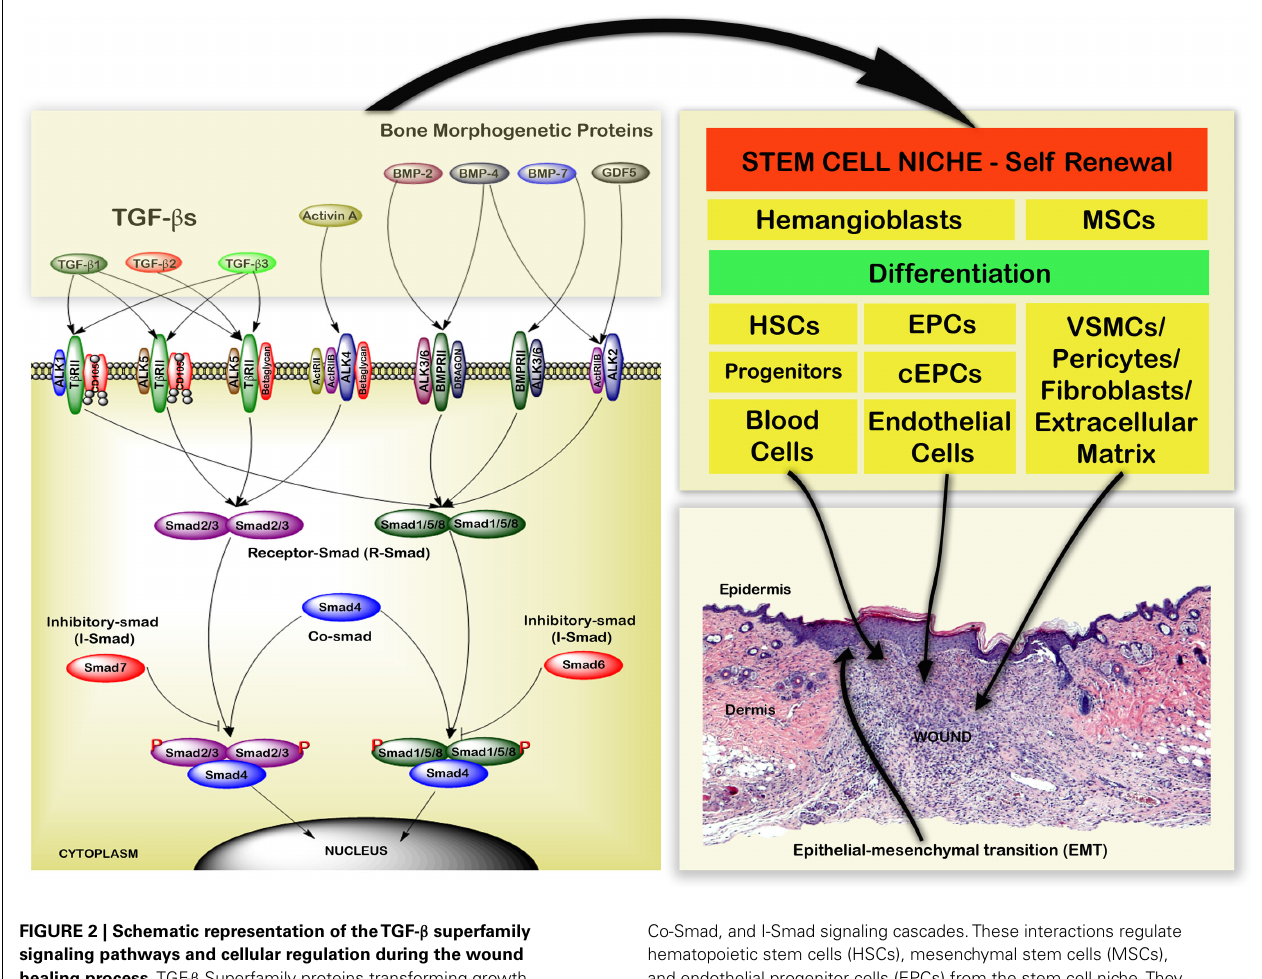
FIGURE 2 | Schematic representation of theTGF- β superfamily signaling pathways and cellular regulation during the wound healing process. TGF- β Superfamily proteins transforming growth factor beta (TGF- β ), growth differentiation factors (GDFs), activin, and bone morphogenetic proteins (BMPs) bind toType I, II, and III receptor complexes.This leads to activation of intracellular R-Smad,